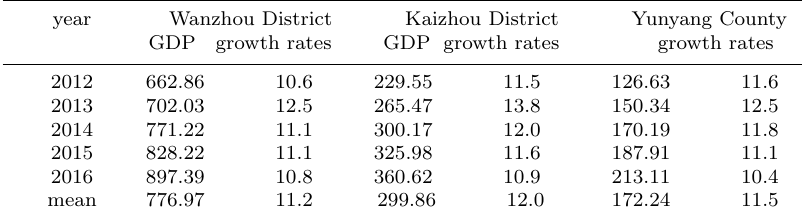
Table 1. The gross domestic product and economic growth rate of Wanzhou District, Kaizhou District, and Yunyang